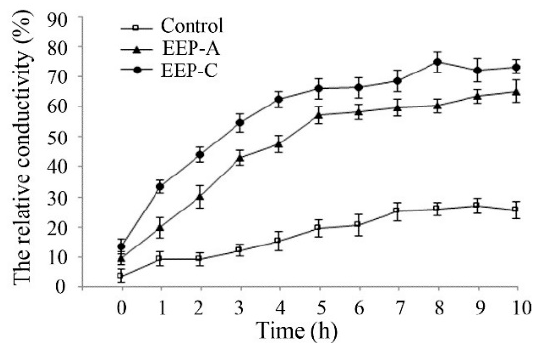
ff ect of EEP on the cell membrane permeability of P. Figure 4. Effect of EEP on the cell membrane permeability of P. notatum. Figure 4. E Figure 4. Effect of EEP on the cell membrane permeability of P. notatum. Figure 4. Effect of EEP on the cell membrane permeability of P. notatum.